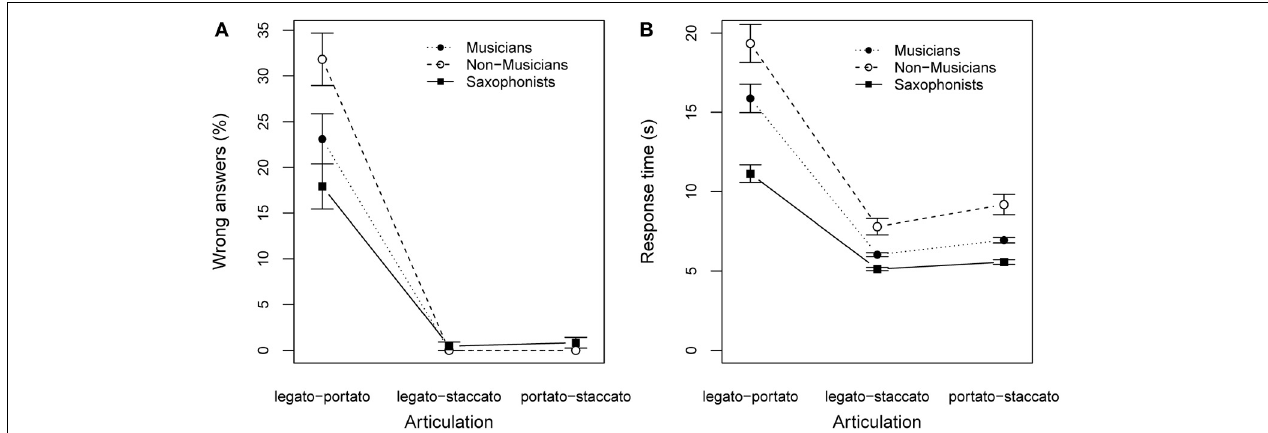
FIGURE 8 | Results of listening experiment: (A) percentage of mistakes for discrimination task; (B) response time to accomplish the task; Participants were grouped by their expertise in music making. Error bars show the standard error of the